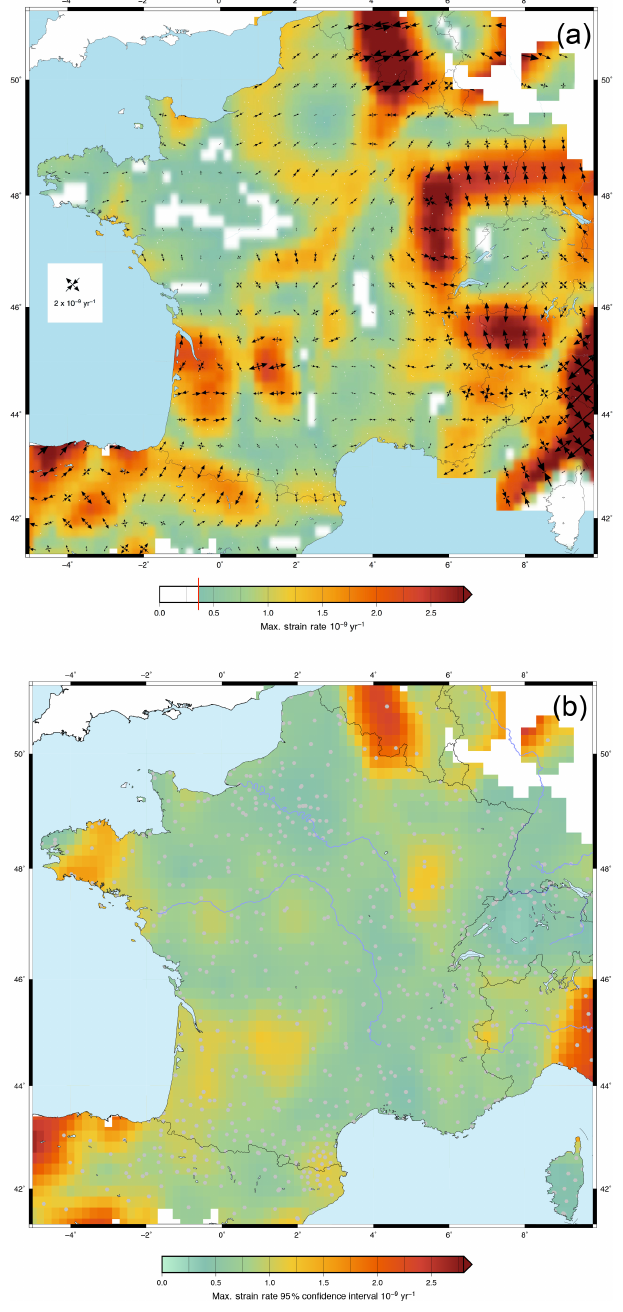
Figure 7. (a) Smoothed horizontal strain rate field with a grid of 0.1 ◦ (strain rate tensors are plotted every 0.5 ◦ ) and (b) associated 95% confidence interval (CI95).